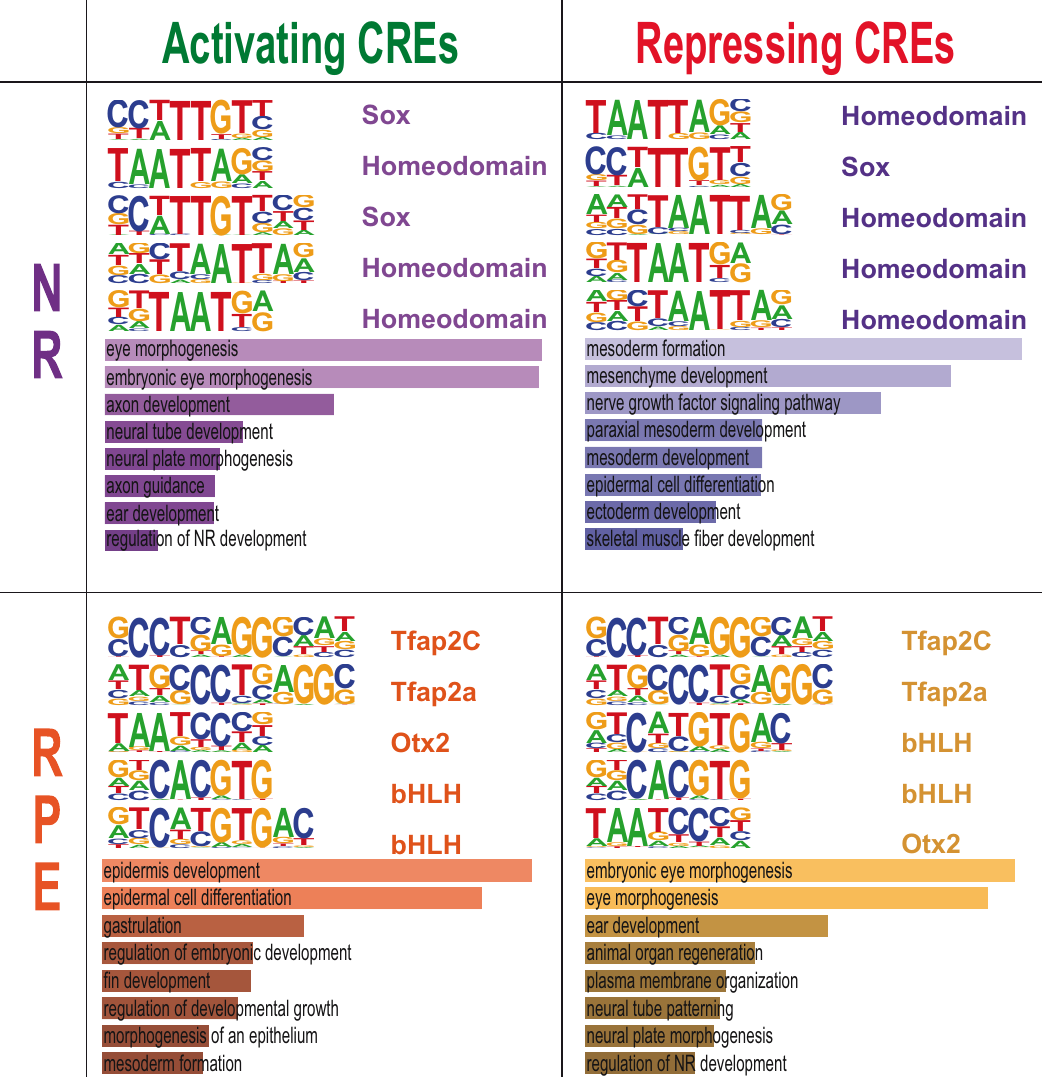
Fig. 6 Motif enrichment analysis of activating and repressing CREs. Representative TF motifs enriched in activating (left column) and repressing (right column) CREs in both the NR and RPE domains. Analysis of GO terms enrichment for genes associated with each set of elements is